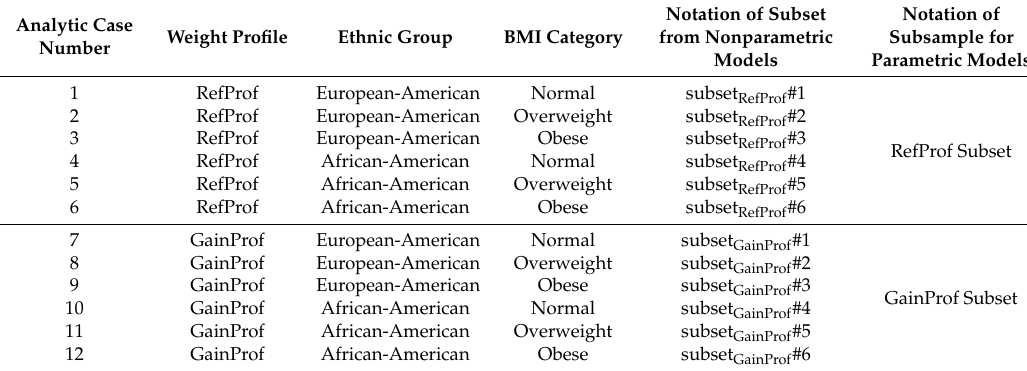
Table 2. Schema of building 12 subsets associated with 12 analytic cases for nonparametric models and 2 subsamples for parametric models for a given